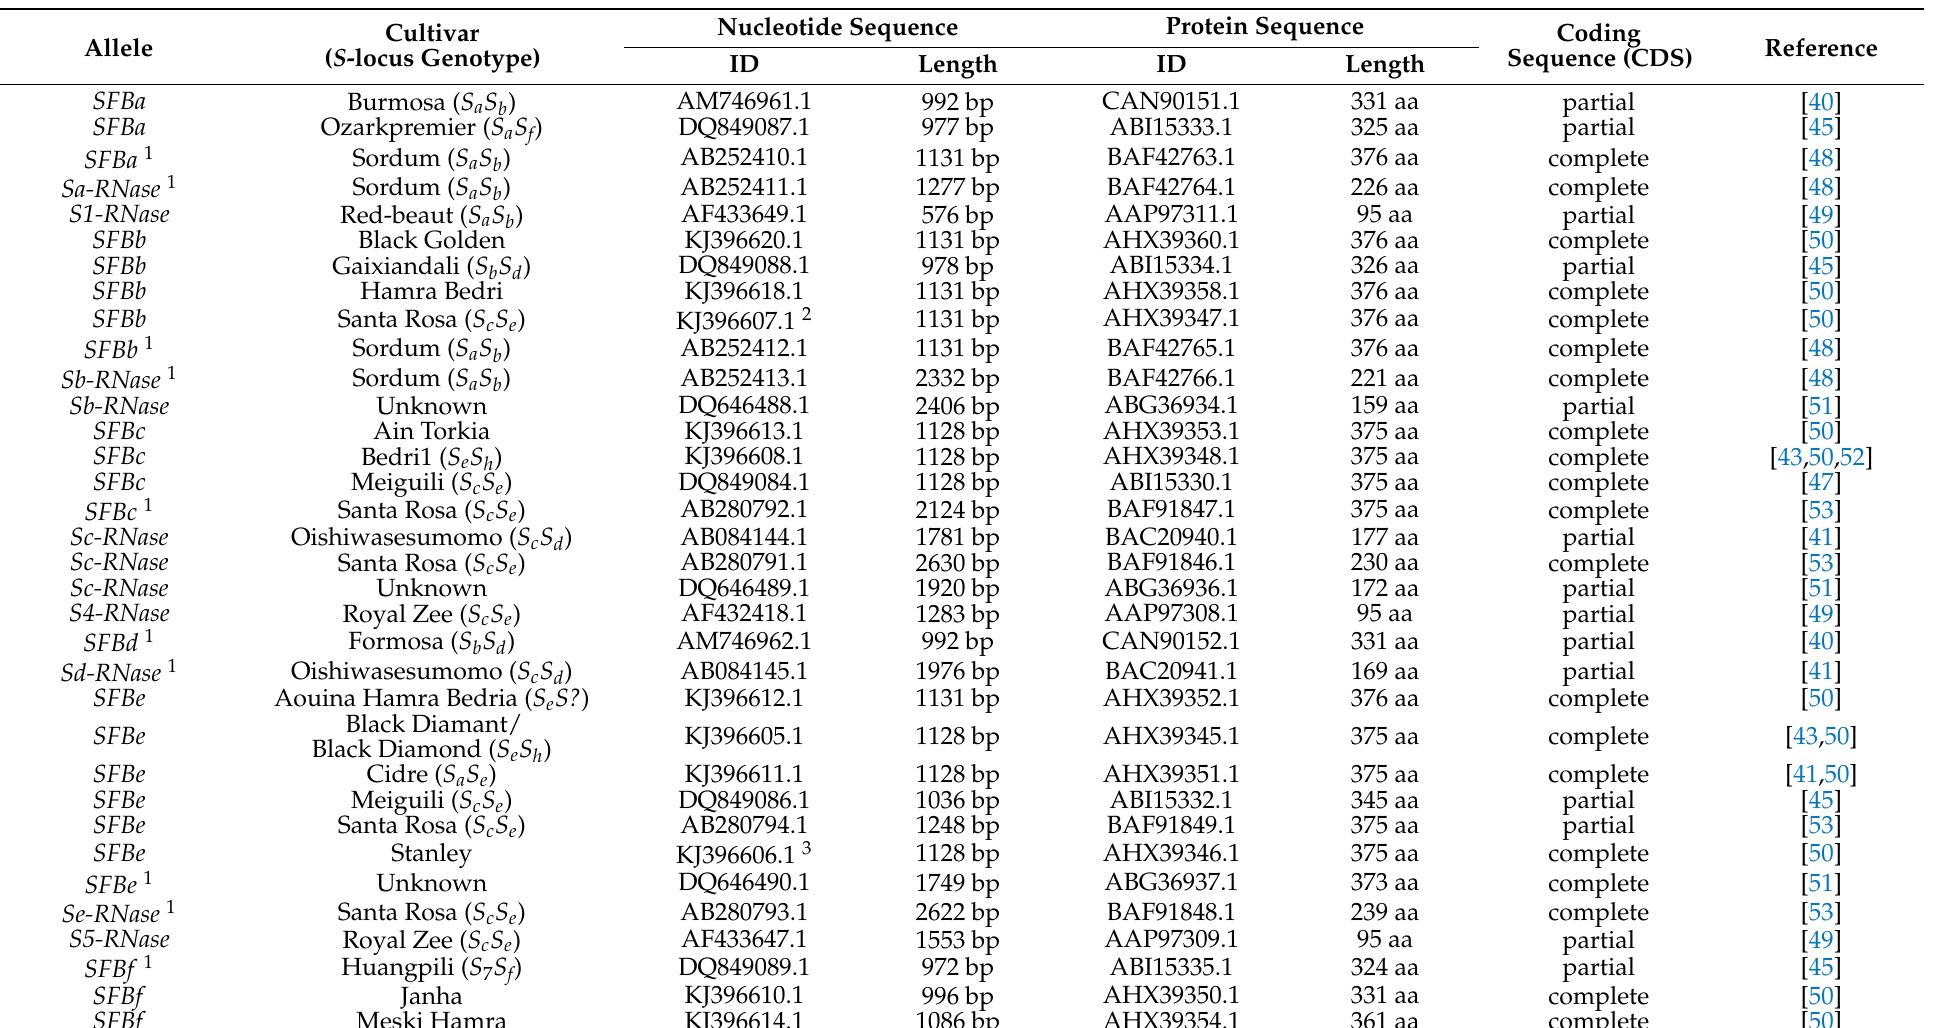
Table 1. Prunus salicina SFB and S-RNase allele sequences deposited at GenBank. Sequences used to build the concatenated artificial sequence are